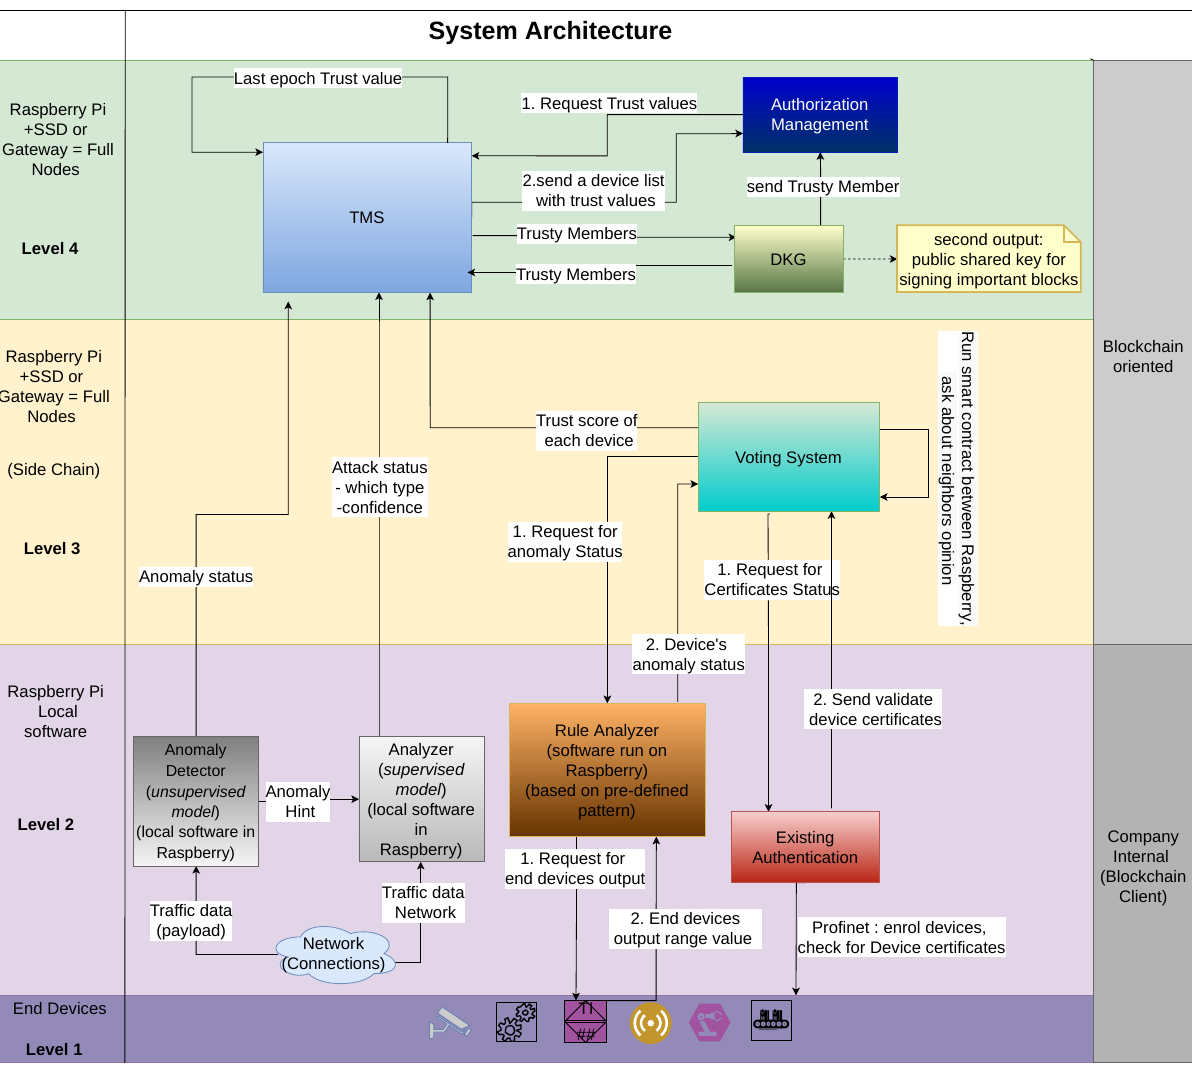
Figure 2. Hierarchy diagram of the Schloss system